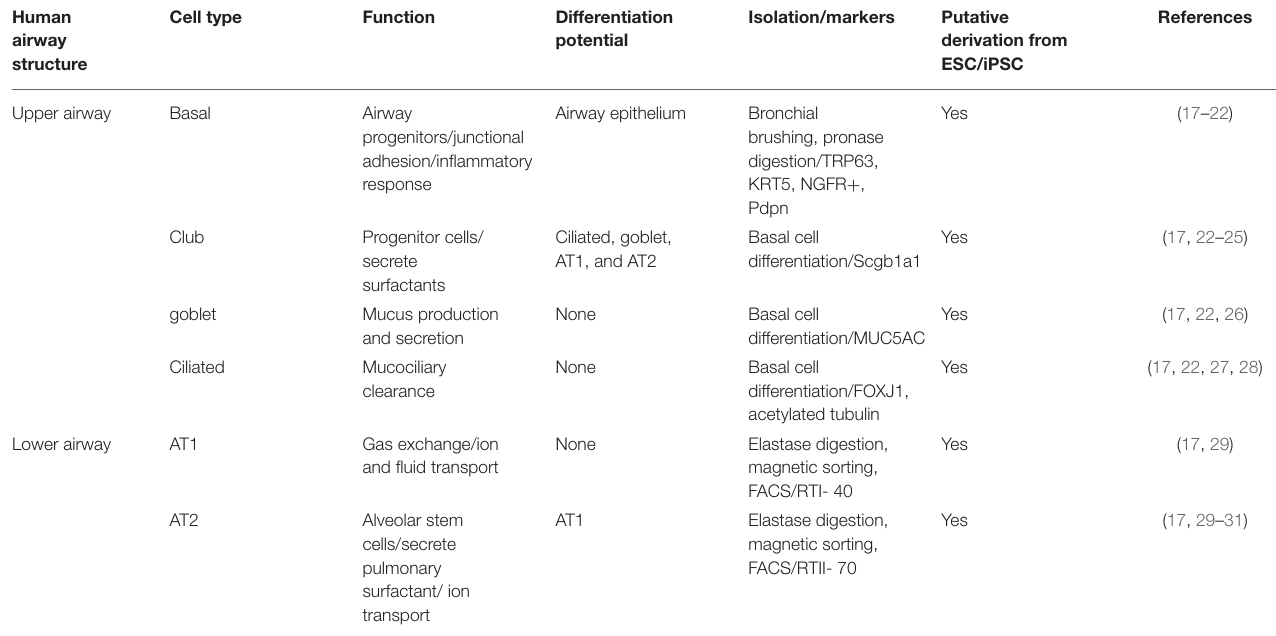
TABLE 1 | Summary of human airway structure, cellular composition, cellular characteristics, differentiation potential, and derivation from embryonic stem cells (ESC) and induced pluripotent stem cells (iPSC). Human